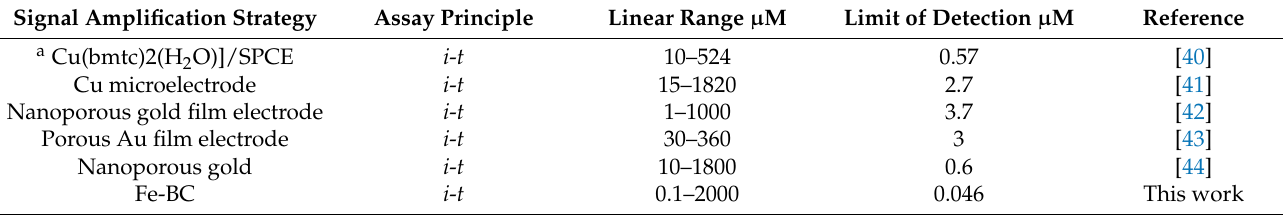
Table 1. Comparison with previous